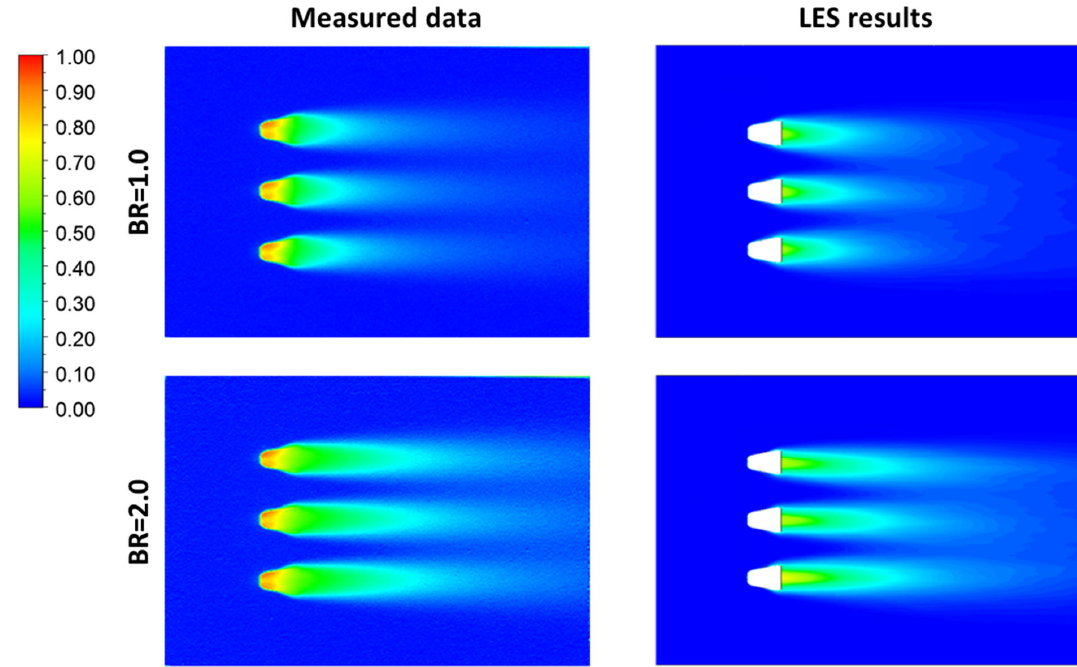
Figure 11. Comparison of film cooling effectiveness distribution between measured data and LES results according to the blowing ratio.